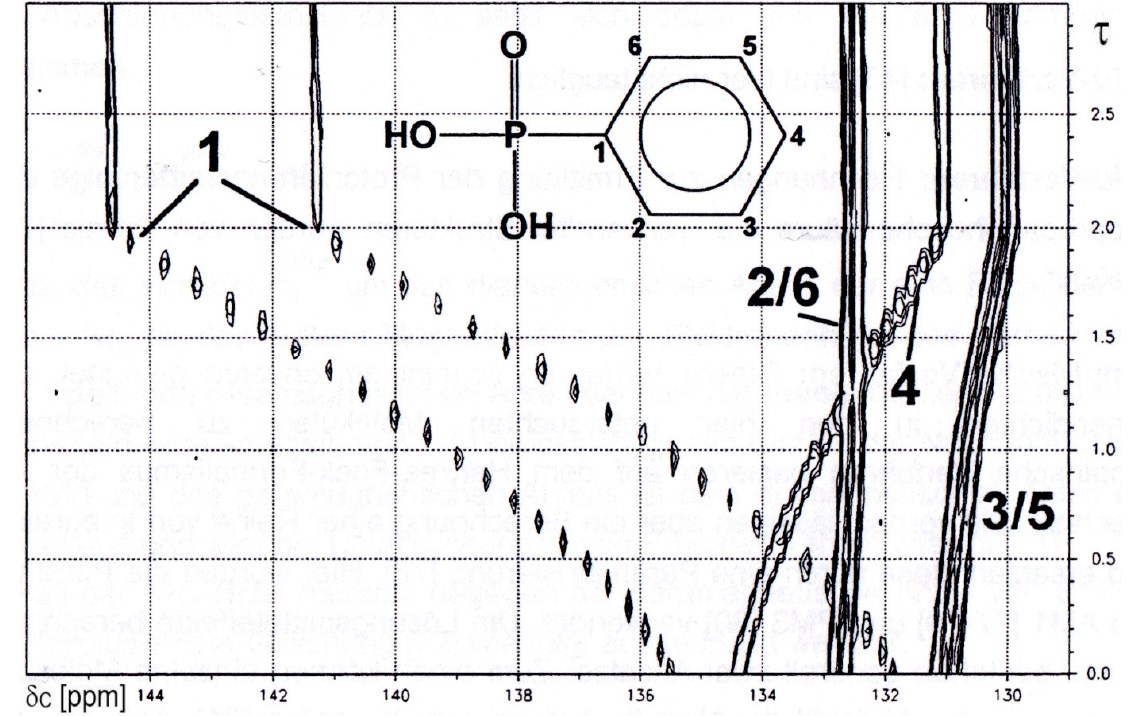
Figure 2. 13 C{ 1 H}-NMR-controlled titration of phenylphosphonic acid 2 vs. KOH yielded a contour plot for chemical shift δ C as a function of the degree of titration τ . X -axis: δ C [ppm]. Y -axis: degree of titration τ .